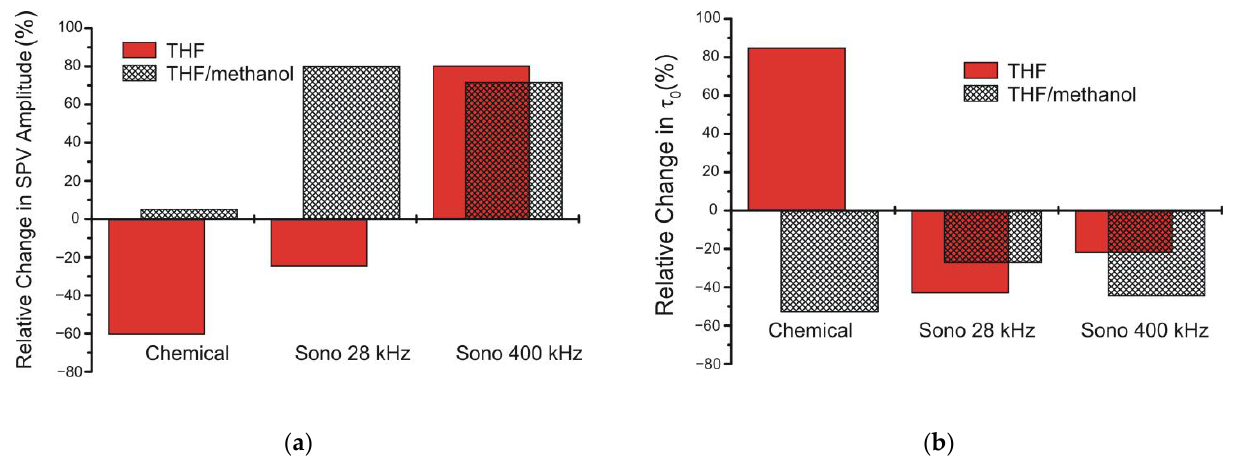
Figure 7. Relative change in the SPV amplitudes ( a ) and decay times 𝜏 0 ( b ) due to exposure of Si to tetrahydrofuran and sonication in tetrahydrofuran at about 28 and 400 kHz (red rectangles). Black rectangles are measured when using a mixture of tetrahydrofuran and methanol. The data in ( a ) are obtained from Figure 4 at time moment 𝑡 = 0 and that in ( b ) by fitting the decays in Figure 6a to Equation (19).